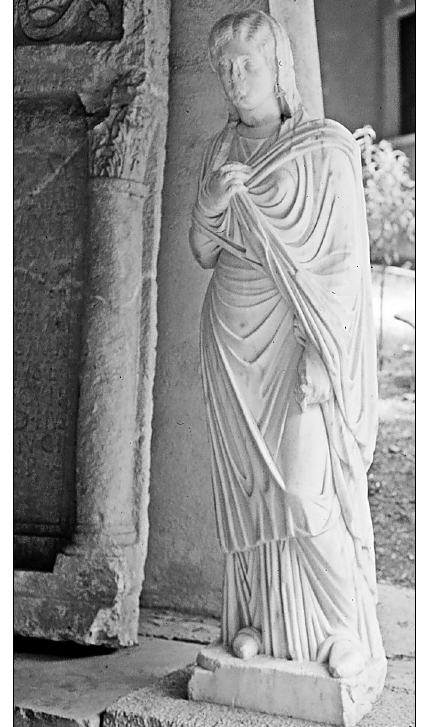
Figure 3 The Roman marble statue found in burial mound XXX at Novio- dunum by Gavrila Simion.